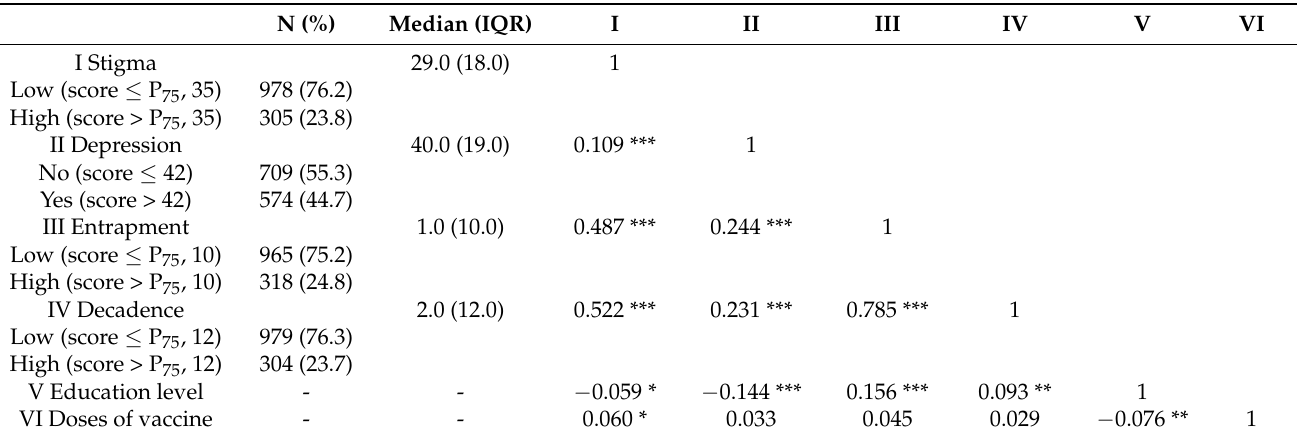
Table 2. Psychological scores and relationship between variables in